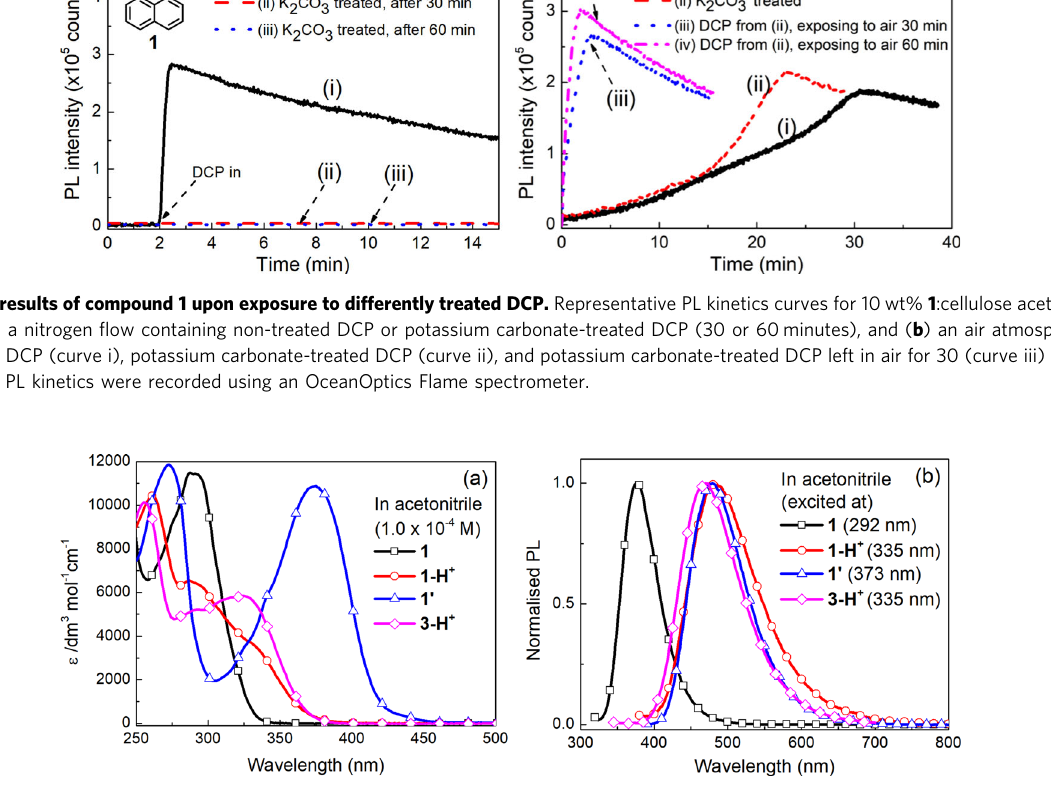
Fig. 7 The optical properties of 1, 1-H + , 1 ’ , and 3-H + in acetonitrile. a UV – vis and b PL